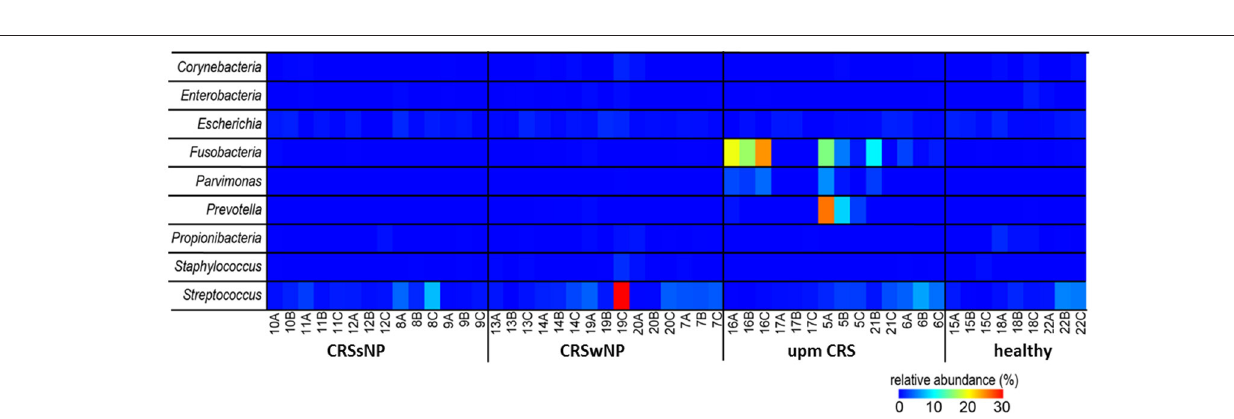
FIGURE 5 | Comparison of the successfully isolated bacteria (see Table 2 ) and their relative abundance in the cultivation independent analysis. The samples were ordered based on the different CRS types: unilateral purulent maxillary CRS (upm CRS), CRS with nasal polyps (CRSwNP), and CRS without nasal polyps (CRSsNP). For detailed information of each sample refer to Table 3